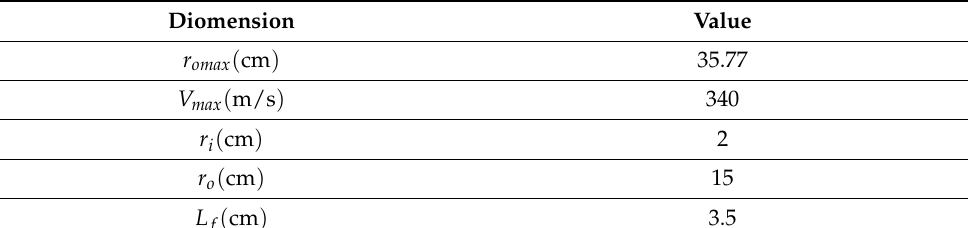
Figure 10. The geometrical structure of FESS. Table 3. The geometrical dimensions of the designed flywheel disk.